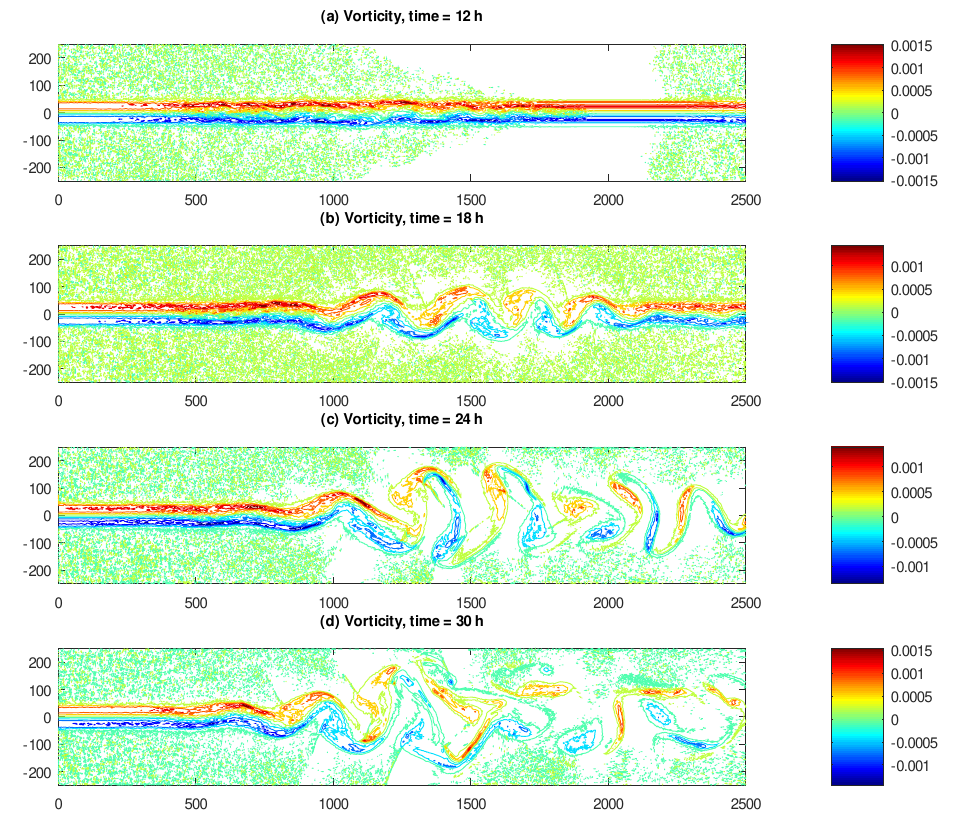
Figure 2. Vorticity of the inertial flow, expressed in s − 1 , and captured at ( a ) 12, ( b ) 18, ( c ) 24 and ( d ) 30 h of elapsed model time. The domain size is 2500 × 500 km.